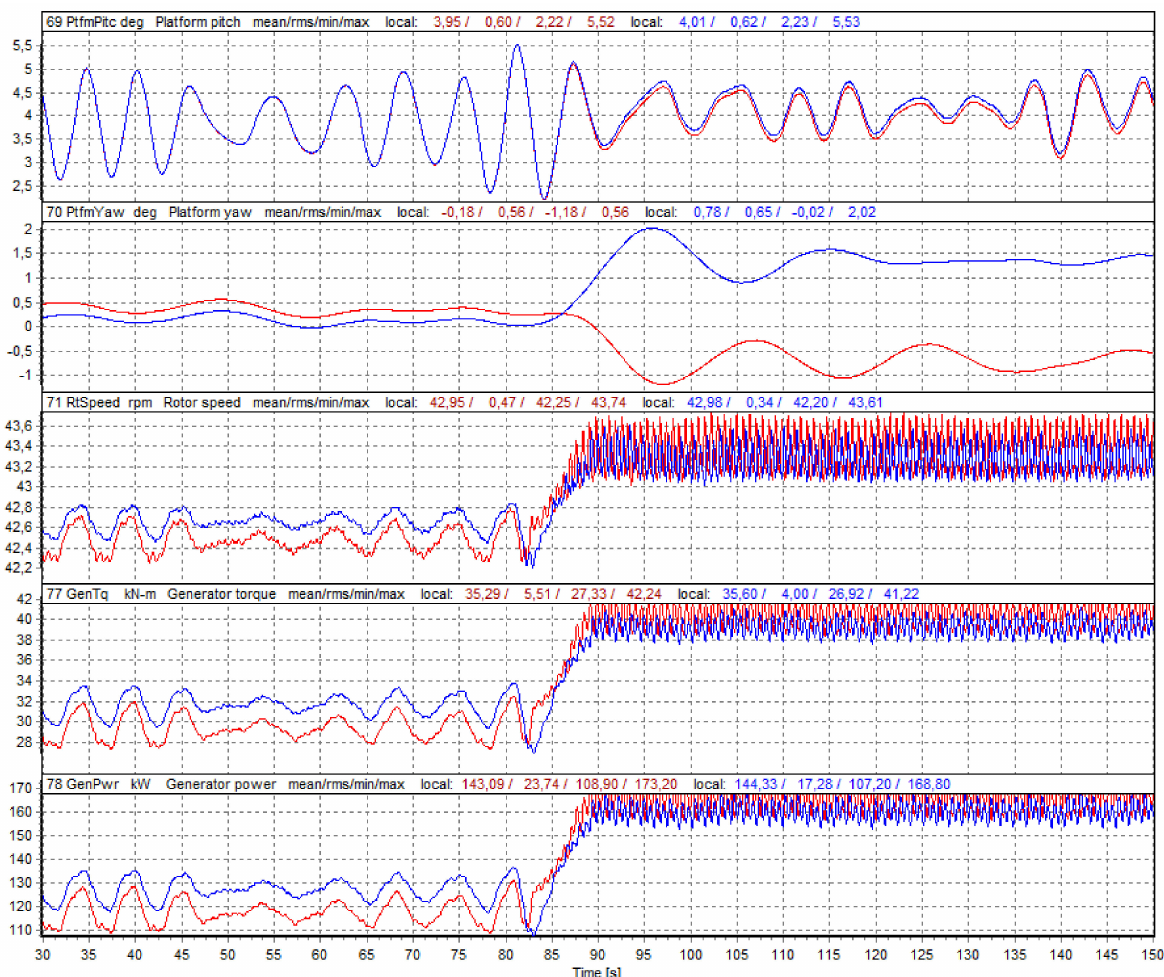
Figure 5. Time histories from DLC 1.4 simulation number 6 (shown in red) and simulation number 431 (shown in blue) for the offshore CART system